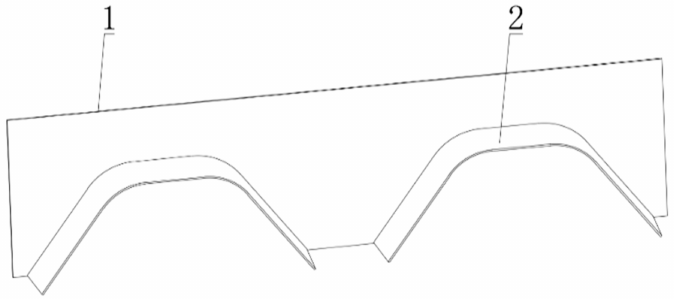
Figure 5. Ridge body forming parts: 1. Connecting plate; 2. Ridge body forming